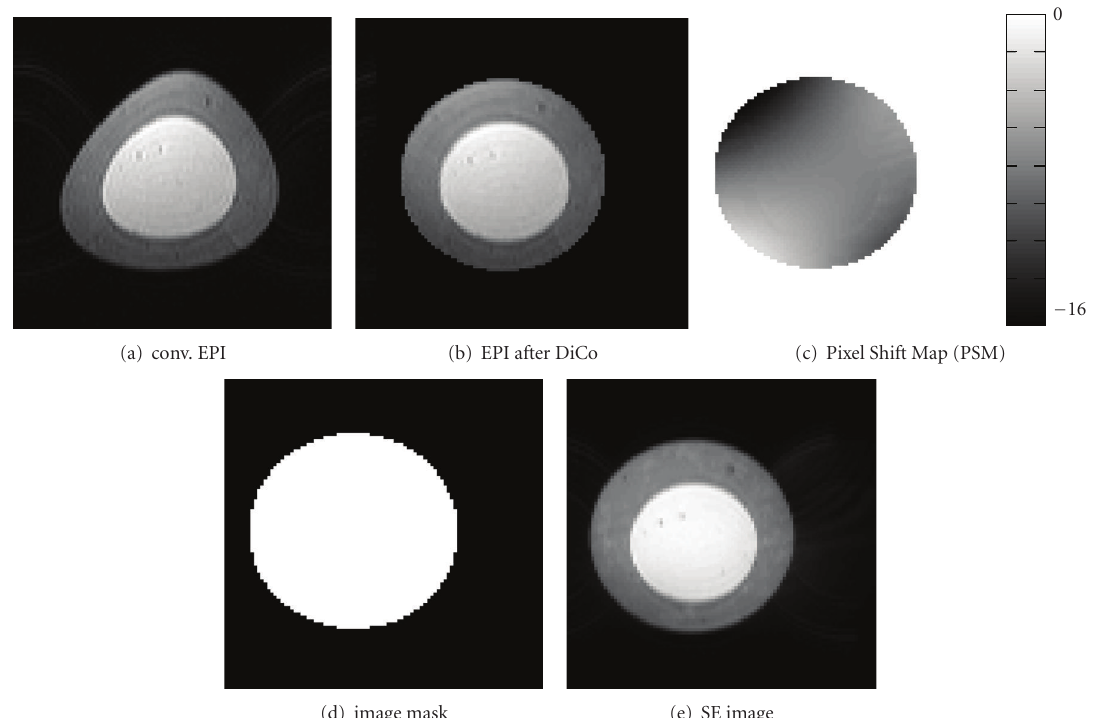
Figure 3: Results from the application of the distortion correction on a phantom. (a) Conventional SE-EPI. The cylindrical object is clearly deformed. (b) SE-EPI after DiCo shows improved geometric properties of the phantom. (c) Pixel Shift Map calculated from PSF data and applied to the EPI during the correction process. In addition, the object mask (d) and a nondistorted Spin Echo (e) image are shown, which were calculated from the PSF data. Note that ghosting artifacts are visible outside the phantom in conventional EPI (a). Due to the application of the correction process inside the object mask (d) no ghosting can be identified in